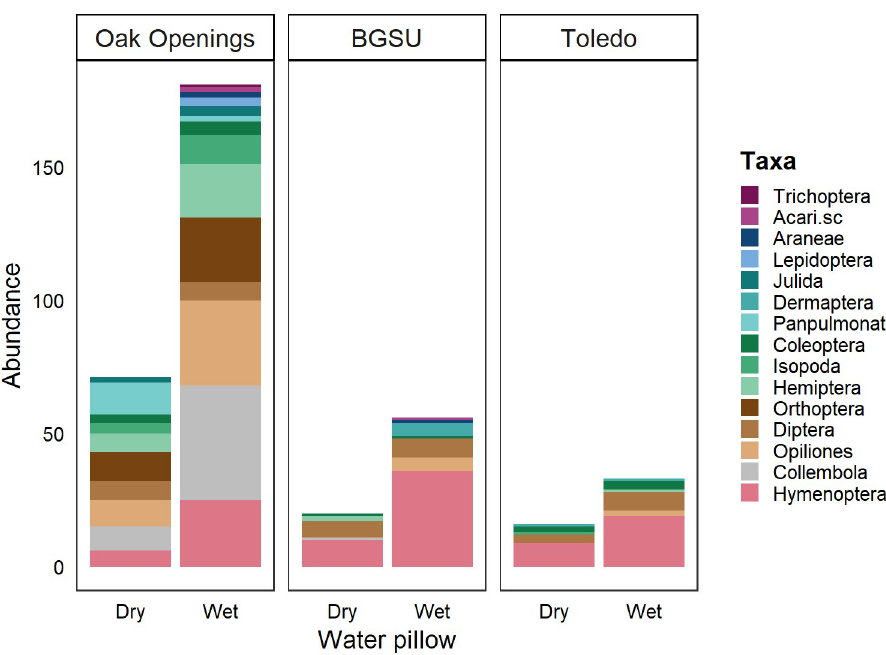
Fig 3. Total abundance of terrestrial arthropods and mollusks on wet and dry pillows. Responses to water pillows were dominated by Opiliones, Orthoptera, Hymenoptera, and Collembola at the undeveloped sites (Oak Openings), while developed sites (BGSU and Toledo) were primarily composed of Hymenoptera (mostly ants, especially Camponotus , Lasius , and Brachymyrmex ). These genera are widespread in OH and were present at all sites. Ants in Toledo and BGSU were primarily Camponotus pennsylvanicus